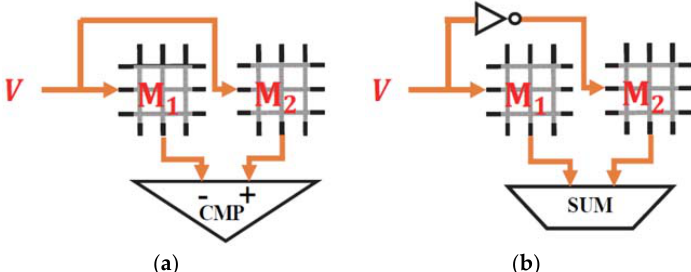
Figure 57. ( a ) Naïve design with a positive voltage applied to both crossbar arrays and ( b ) revised design with a positive voltage applied to the first crossbar array and a negative voltages applied to the second crossbar array.